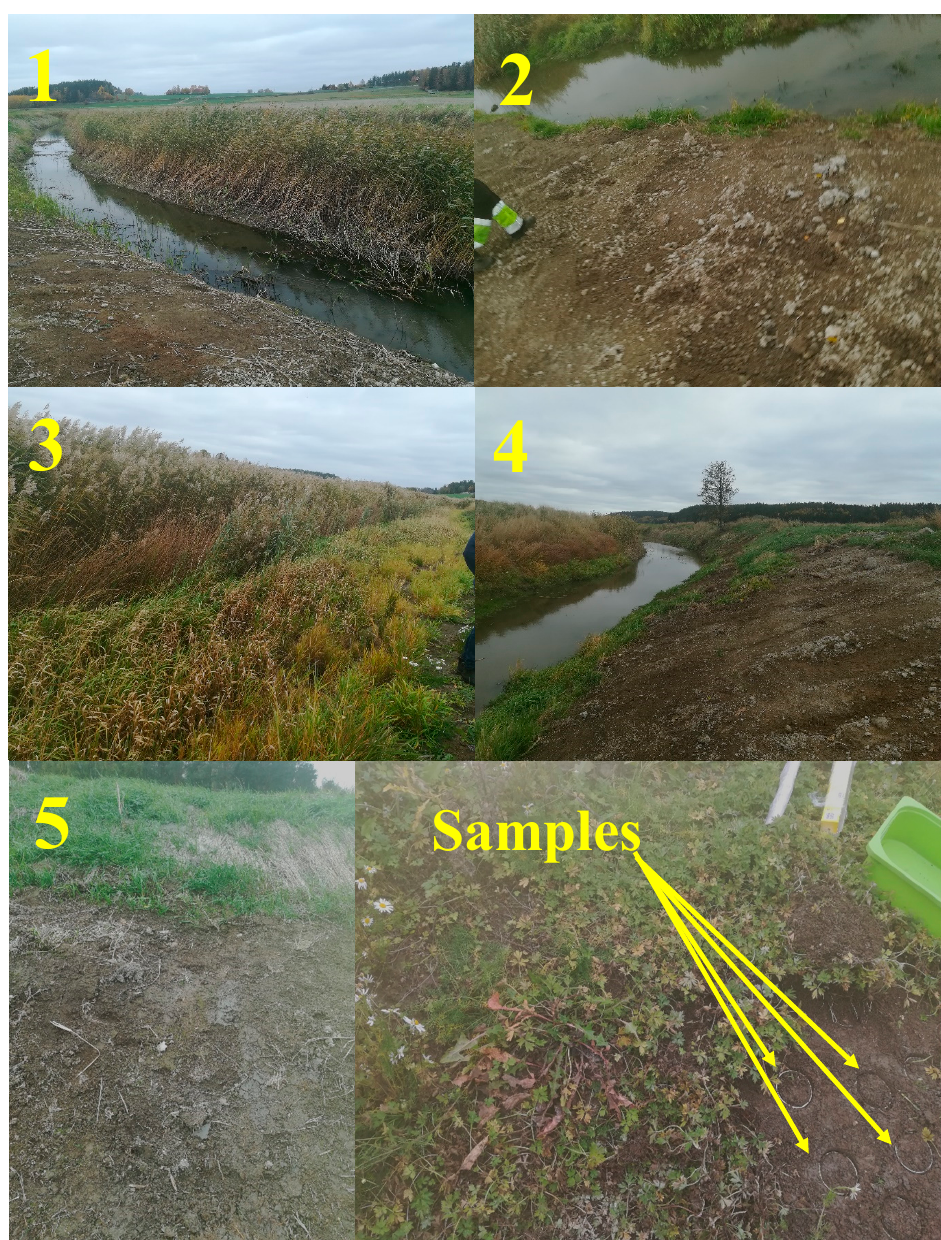
Figure 2. (Images 1–5) The five ditch segments surveyed. Segments 1 and 3 seemed to be stable and were vegetated, whereas segments 2, 4, and 5 had had their vegetation removed and / or cross-section modified during recent maintenance work. (Bottom right) Soil sampling locations on the ditch bank.